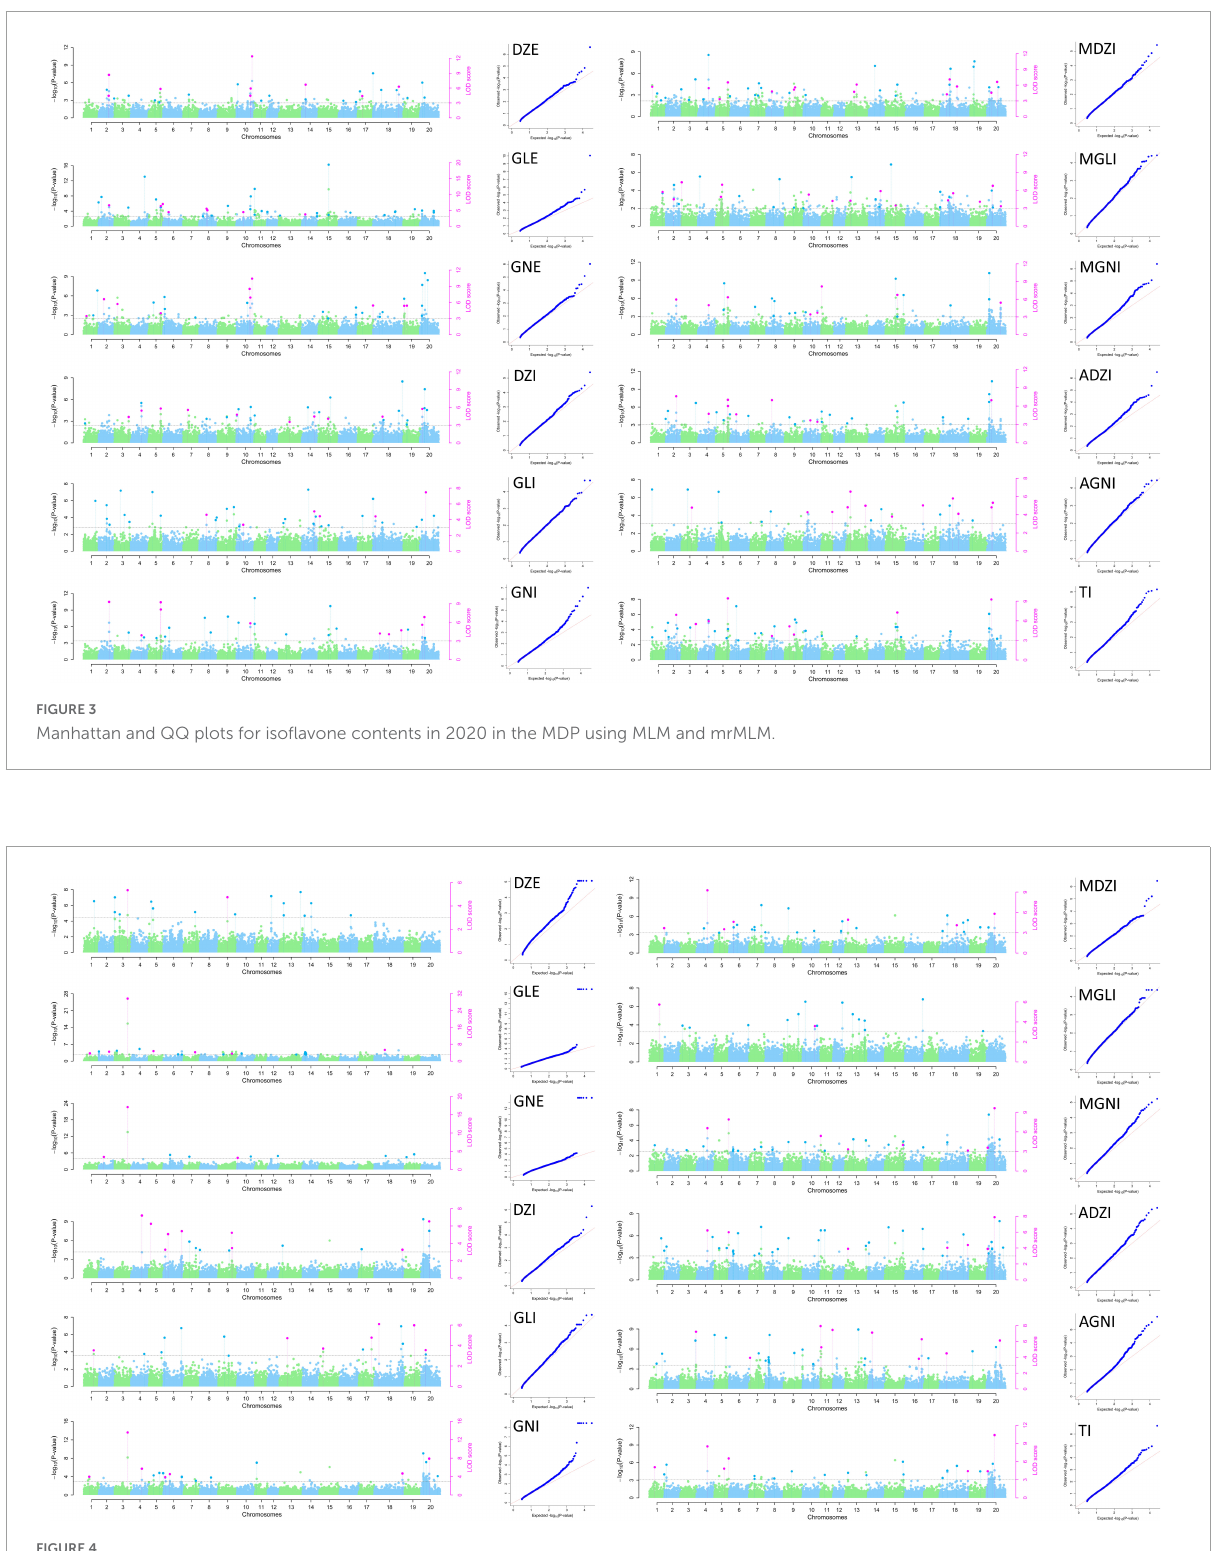
Frontiers in Plant